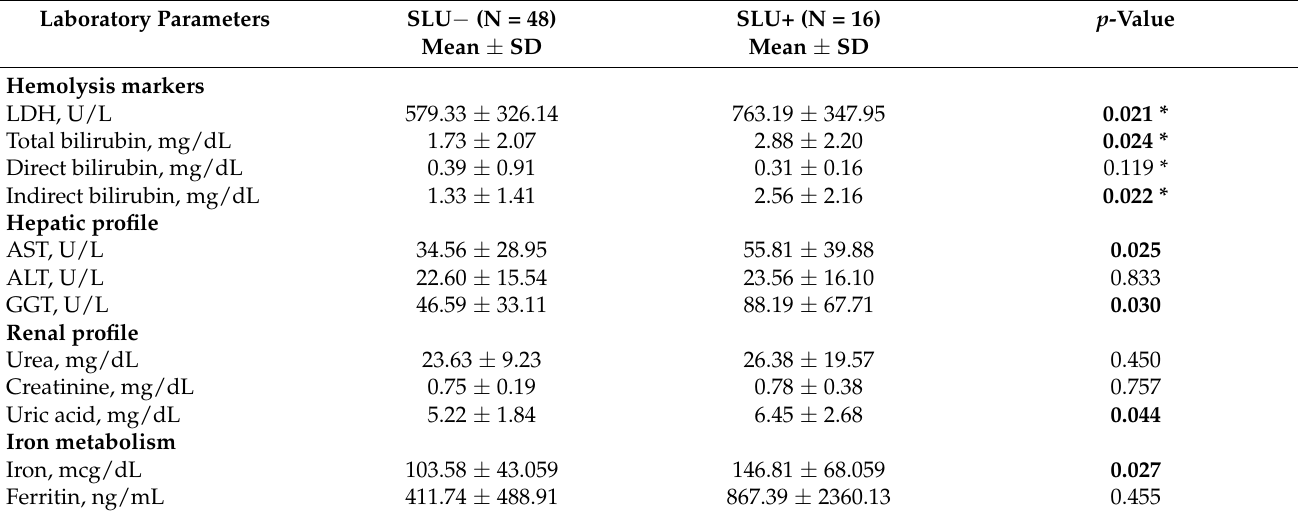
Table 3. Biochemical characterization of SLU − and SLU+